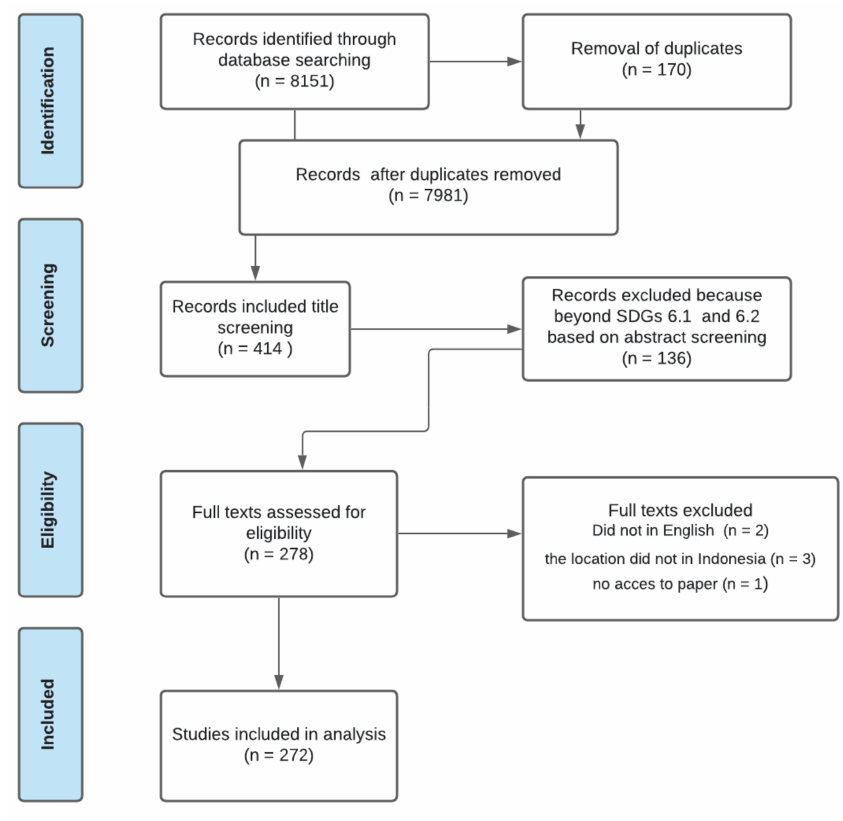
Figure 1. Diagram of the screening process and selected